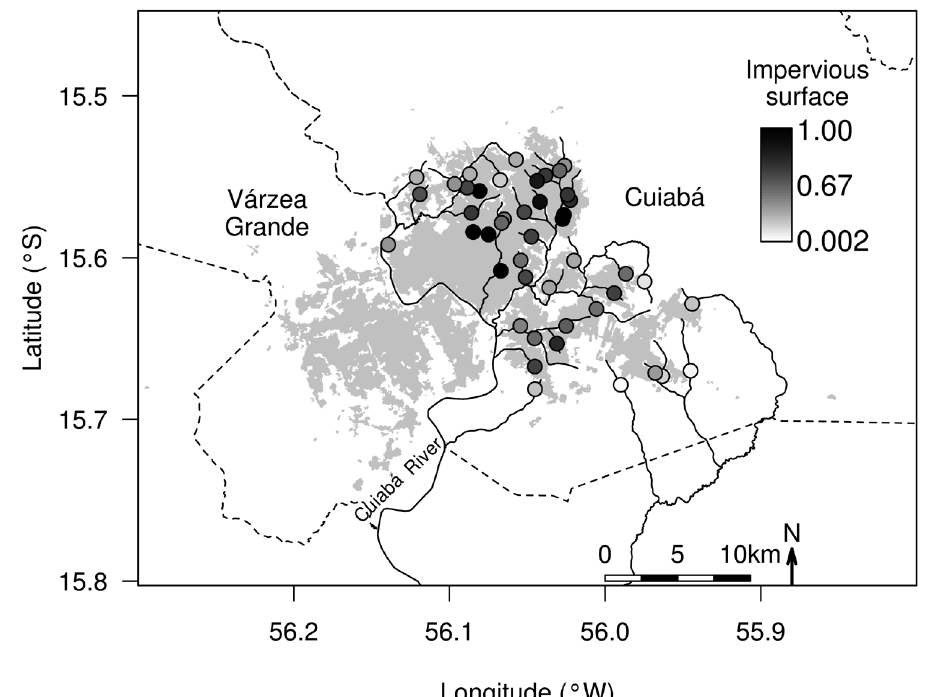
FIGURE 1 | Location of the 45 streams sampled for fish in urban area within Cuiabá, Mato Grosso state, midwestern Brazil. The gray area indicates impervious surfaces. The color gradient indicates the proportion of impervious surfaces in a 500 m buffer around each stream; the closer to one the value is, the higher the quantity of urban infrastructure around the stream. The continuous lines indicate the hydrography. The dashed lines indicate the political boundary of Cuiabá with the neighboring municipality of Várzea